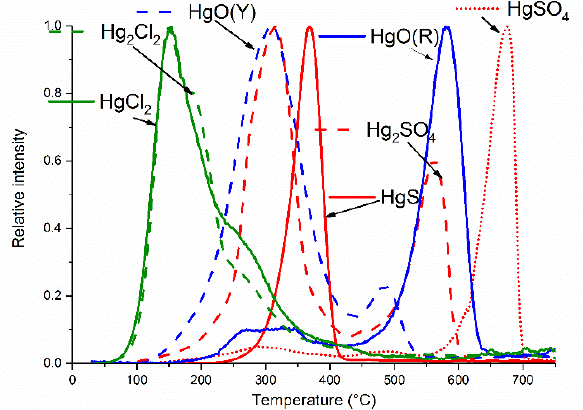
Figure 6: TPD spectra of mercury compounds in precipitates prepared by wet mixing various Hg-compounds in a saturated solution of CaSO ·2H O. Note: The absence of HgS peak is due to its low 4 2